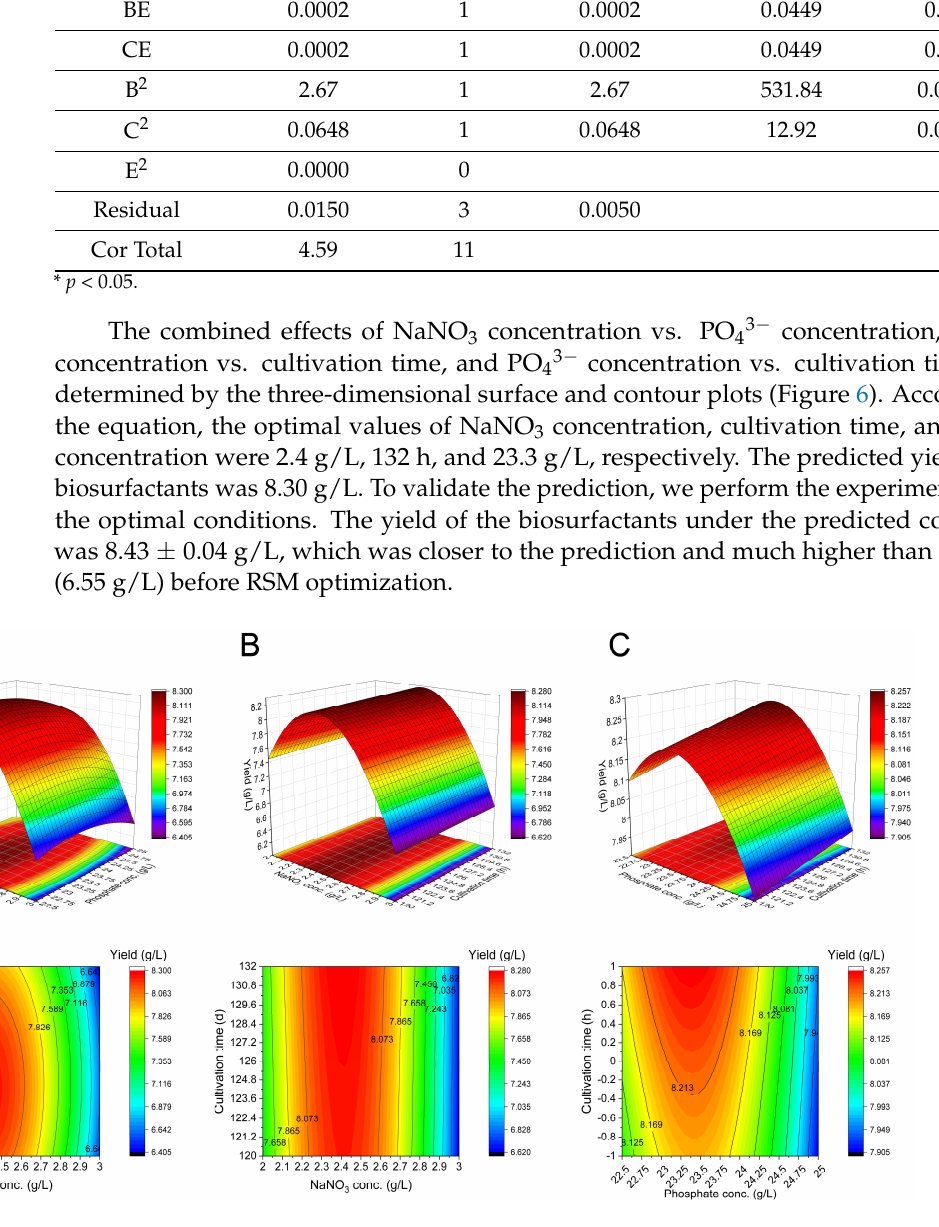
Figure 6. Three-dimensional surface and contour plots showing the interactions of factors on the biosurfactants yield. ( A ) Interactions between NaNO 3 concentration and PO 4 3− concentration ( B ) Interactions between NaNO 3 concentration and cultivation time. ( C ) Interactions between PO 4 3 − concentration and cultivation time.